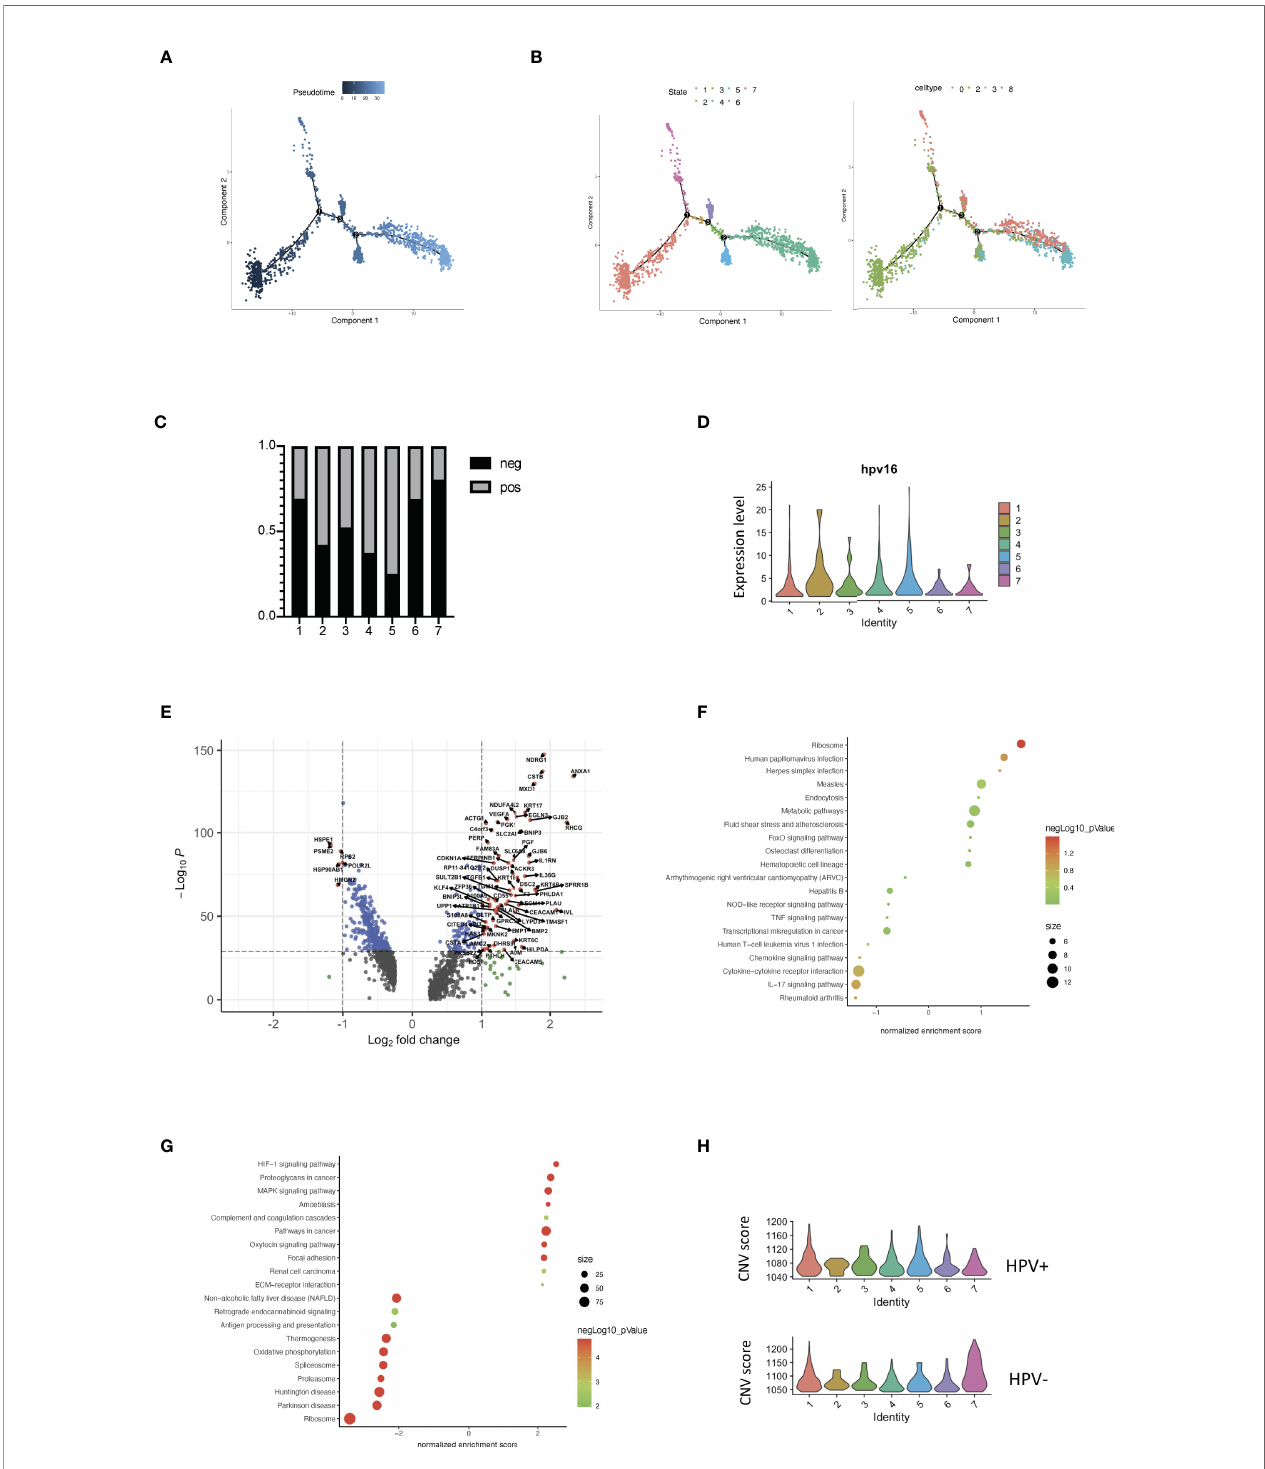
FIGURE 4 | Trajectory analysis of HPV + cervical cancer cells. (A) Pseudotime of cervical cancer cells. (B) Trajectory analysis of tumor cells in the seven states and in the correlated Seurat clusters (0, 2, 3 and 8). (C) The bar chart indicates the ratio of HPV - and HPV + tumor cells in different trajectory states. (D) Violin plots showing the expression of HPV16 in the seven states. (E) Volcano plots demonstrating the expression patterns and levels of the genes in State 1. (F) The enriched KEGG signaling pathway of GSEA analyses for HPV + State 1 cell-correlated gene signatures. (G) The enriched KEGG signaling pathway of GSEA analyses for cancer stemness (State 1)-correlated gene signatures. (H) CNV scores in different trajectory